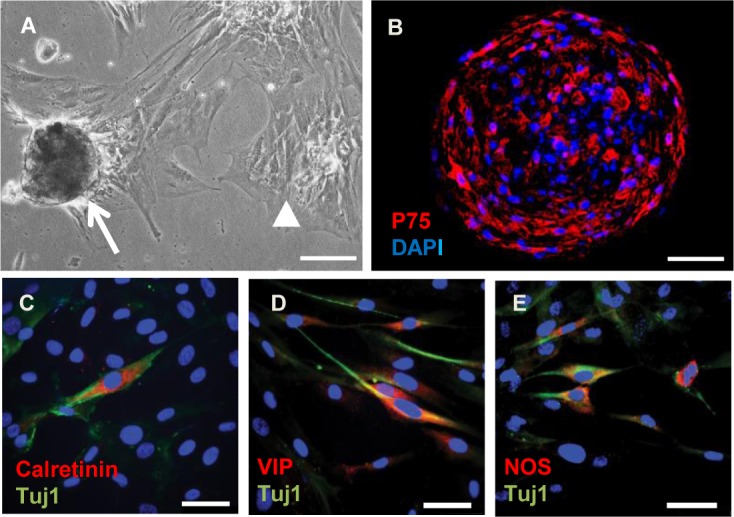
Appearance of neurosphere like-bodies and expression of neuronal markers by neurosphere cells derived from aganglionic Hirschsprung gut.A) Phase contrast photomicrograph of neurosphere-like bodies after 10 days culture. Arrow points to typical loosely attached neurosphere, and arrow head shows clusters of flat cells strongly attached to the substratum. B) Frozen section of neurosphere like body demonstrating cells immunofluorescent for p75 (red), nuclei counterstained with DAPI. C–E) Cells dissociated from the neurosphere-like bodies after 30 days culture followed by immunostaining (red) for calretinin (C), VIP (D), and neuronal NOS (E). The cells were also dual-stained (green) for the pan-neuronal marker Tuj1 and the nuclei counterstained (blue) with DAPI (B—E). Scale bars: A = 100μm; B = 50 μm and C—E = 20μm).